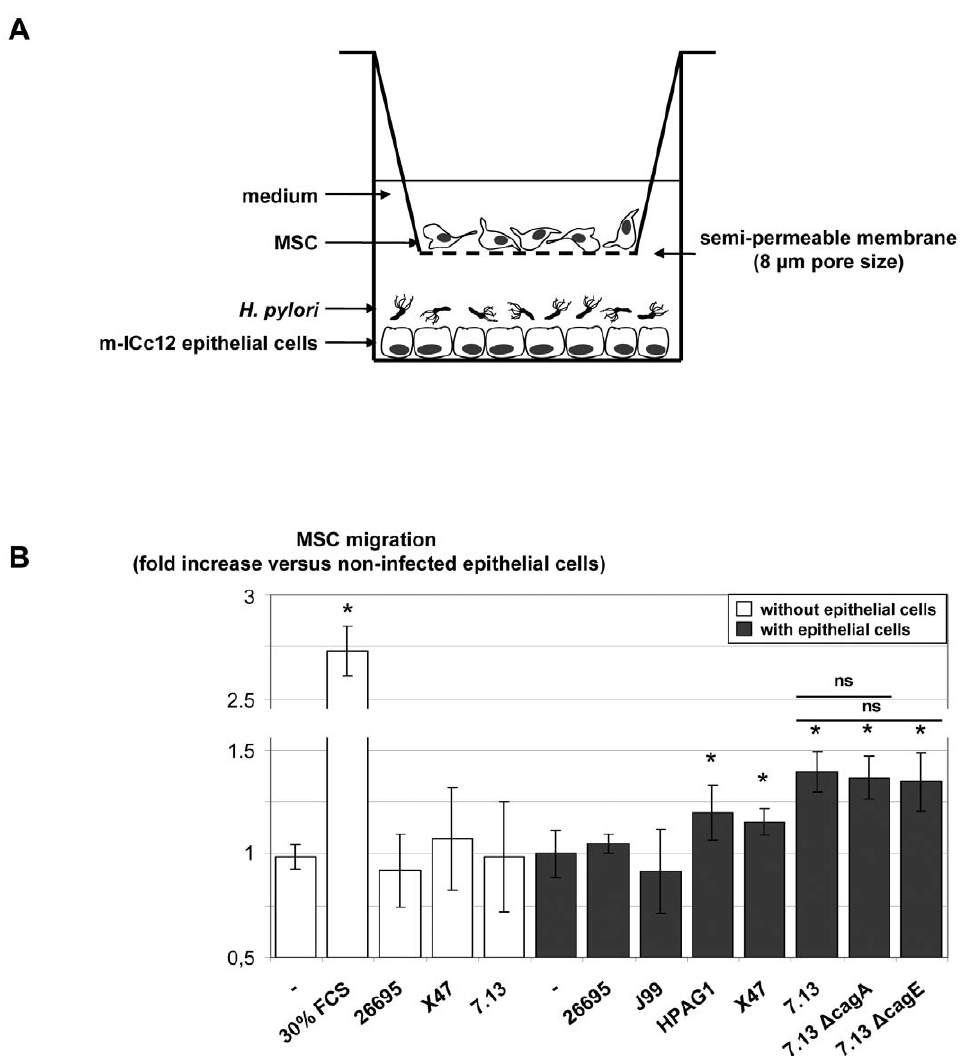
Figure 2. Migration of MSC following Helicobacterpylori infection of gastrointestinal epithelial cells. A/ After a 16 h coculture of epithelial cells with H. pylori , MSC were added to a cell culture insert with a semi-permeable membrane (8 m m pore size). MSC were allowed to migrate for 6 h before being fixed and stained and the number of migrated MSC on the lower side of the filter was determined. B/ MSC migration was evaluated after 6 h coculture with (grey) or without (white) epithelial cells and in the presence or not of 30% FCS and H. pylori 26695, J99,